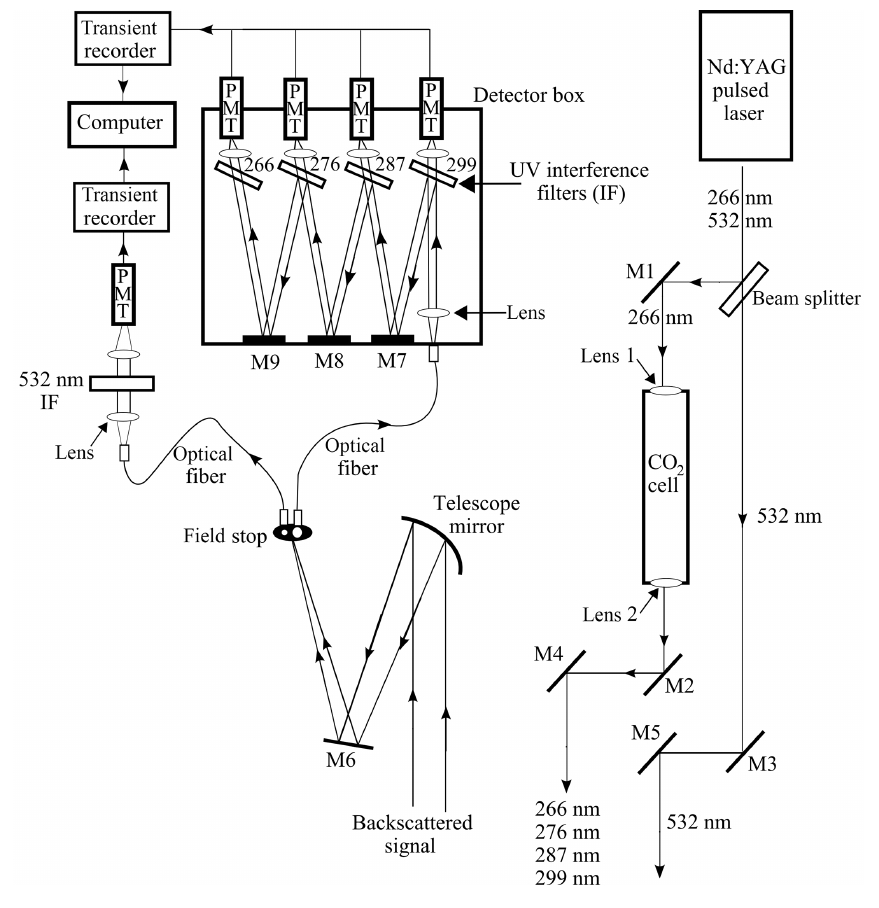
Figure 1. Schematic diagram of the differential absorption lidar system used for measurement of ozone and aerosol during the oil sands field